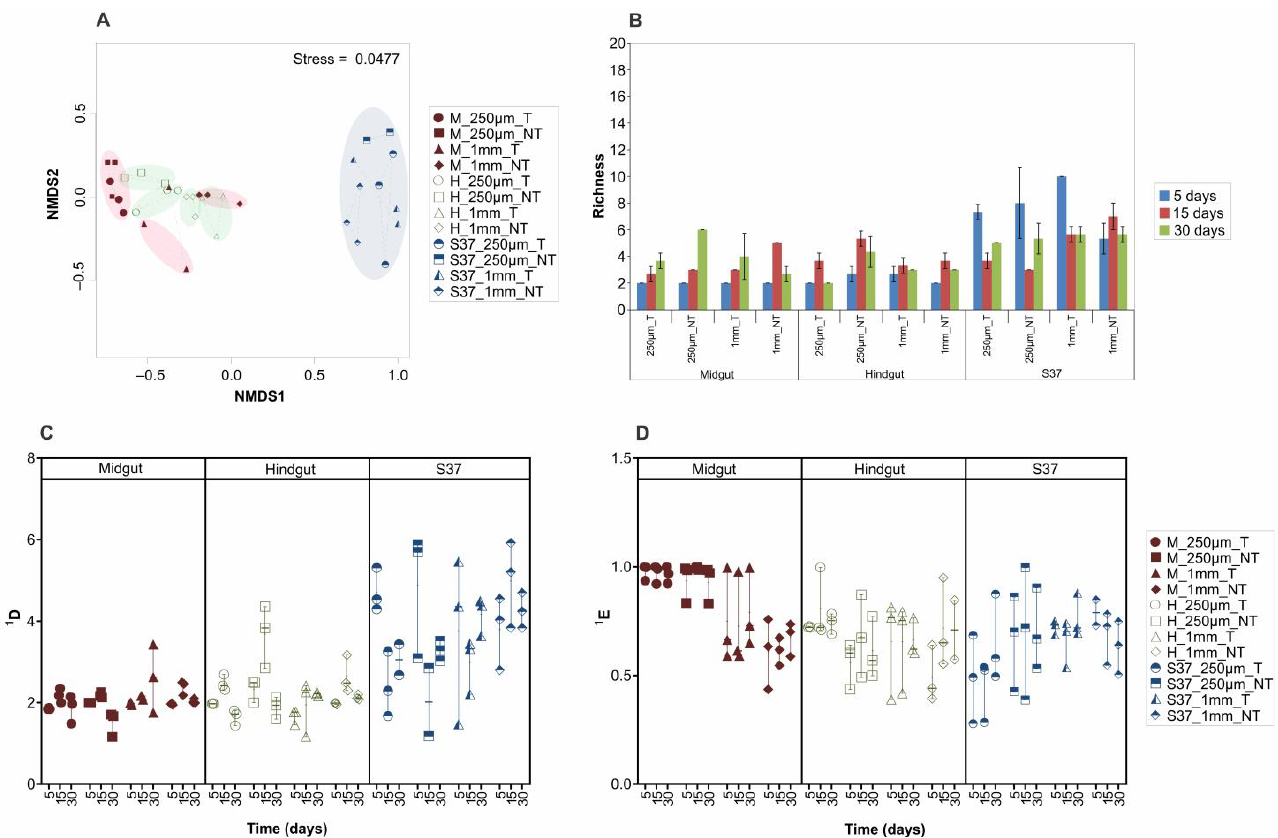
Figure 5. Methanogenic community dynamics and diversity. ( A ) The NMDS plot of the T-RFLP data obtained by BstN I restriction enzyme. Plot based on Bray–Curtis dissimilarity index showing the similarity relationships of the midgut, hindgut and Szarvas soda lake cultures. Microbial communities at 30 days of cultivation. ( B ) Richness. ( C ) Diversity of order 1. ( D ) Evenness of order 1. Colors and symbols were used to indicate the different cultures as follows: red: midgut, green: hindgut, blue: S37. To differentiate between treatments across cultures the following coding was used: circles symbols: 250 µ m_T, square symbols: 250 µ m_NT, triangle symbols: 1mm_T, rotated square symbols: 1mm_NT.